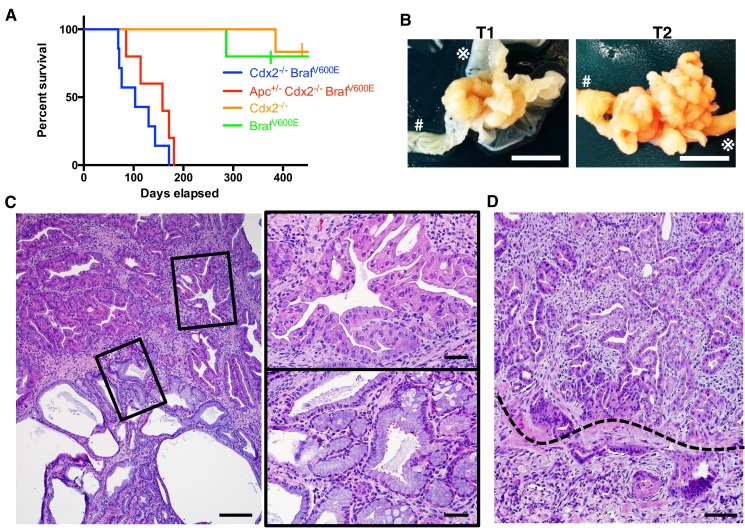
Characteristics of CDX2P-CreERT2 Cdx2fl/fl BrafCA mice.(A) Kaplan-Meier curves of CDX2P-CreERT2 Cdx2fl/fl BrafCA (Cdx2-/- BrafV600E, n = 7), CDX2P-CreERT2 Apcfl/+Cdx2fl/fl BrafCA (Apc+/- Cdx2-/- BrafV600E, n = 5), CDX2P-CreERT2 Cdx2fl/fl (Cdx2-/-, n = 6), and CDX2P-CreERT2 BrafCA (BrafV600E, n = 5) mice, after two daily doses of TAM (150 mg/kg). p<0.002 when comparing Cdx2-/- or BrafV600E to Cdx2-/- BrafV600E or Apc+/- Cdx2-/- BrafV600E by log-rank test; p=0.158 when comparing Cdx2-/- BrafV600E to Apc+/- Cdx2-/- BrafV600E by log-rank test. (B) Macroscopic image of the tumors at the proximal colon-cecum-ileum junction of CDX2P-CreERT2 Cdx2fl/fl BrafCA mice. Left: protuberant tumor (T1) located at the proximal colon-cecum-ileum junction; Right: polypoid lesions (T2) that occupied at the entire terminal ileum to cecum region. # indicates the proximal colon; indicates the ileum. Scale bar, 10 mm (C) Histological features of the proximal colon-cecum-ileum junction tumor of CDX2P-CreERT2Cdx2fl/fl BrafCA mice. Two major components were found in the tumor: serrated region (upper right) and mucin-rich region (lower left). Scale bars, 200 μm for low magnification image (left); 50 μm for high magnification images (right). (D) Serrated region showing invasion into submucosa. Dashed-line highlights muscular mucosa. Scale bar, 100 μm. See also Figure 2—source data 1 for panel A.DOI:
http://dx.doi.org/10.7554/eLife.20331.00710.7554/eLife.20331.008Figure 2—source data 1.Raw data for Kaplan Meier analysis shown in Figure 2A.DOI:
http://dx.doi.org/10.7554/eLife.20331.00810.7554/eLife.20331.009Figure 2—source data 2.Tumor size and invasion in CDX2-CreERT2 Cdx2fl/fl BrafCA mice post TAM Injection.